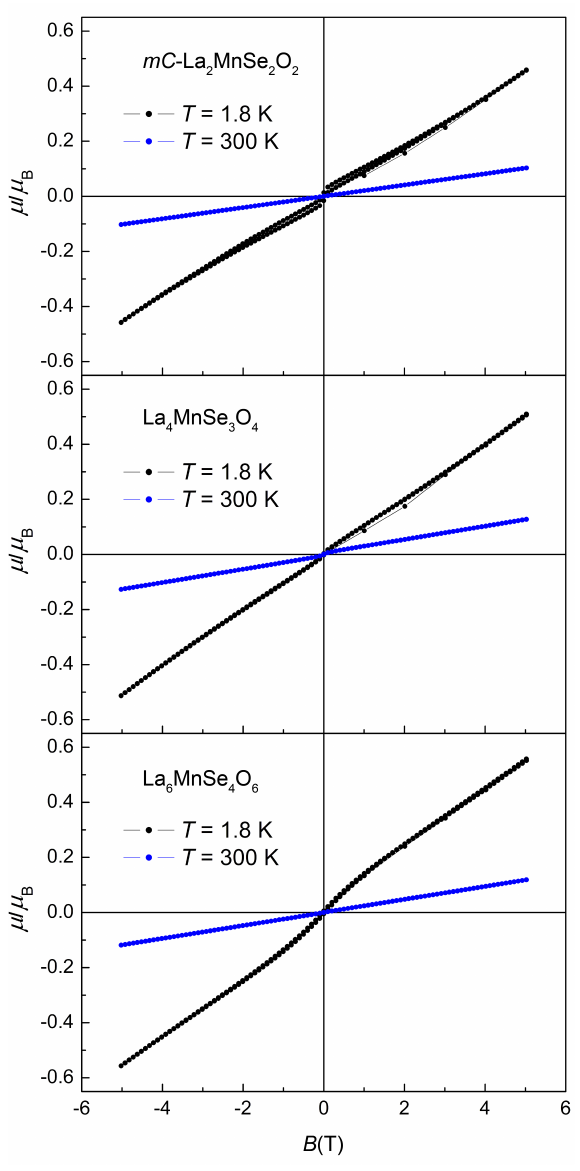
Figure A1. Isothermal magnetization plots at 300 K and 1.8 K of mC -La 2 MnSe 2 O 2 ( top ), La 4 MnSe 3 O 4 ( middle ) and La 6 MnSe 4 O 6 ( bottom